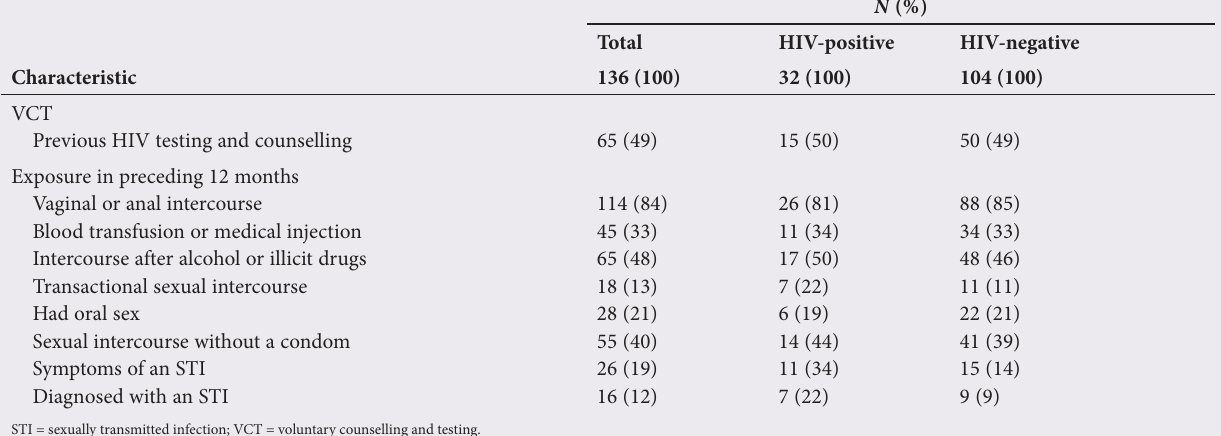
Table 1. Sample characteristics (continued)